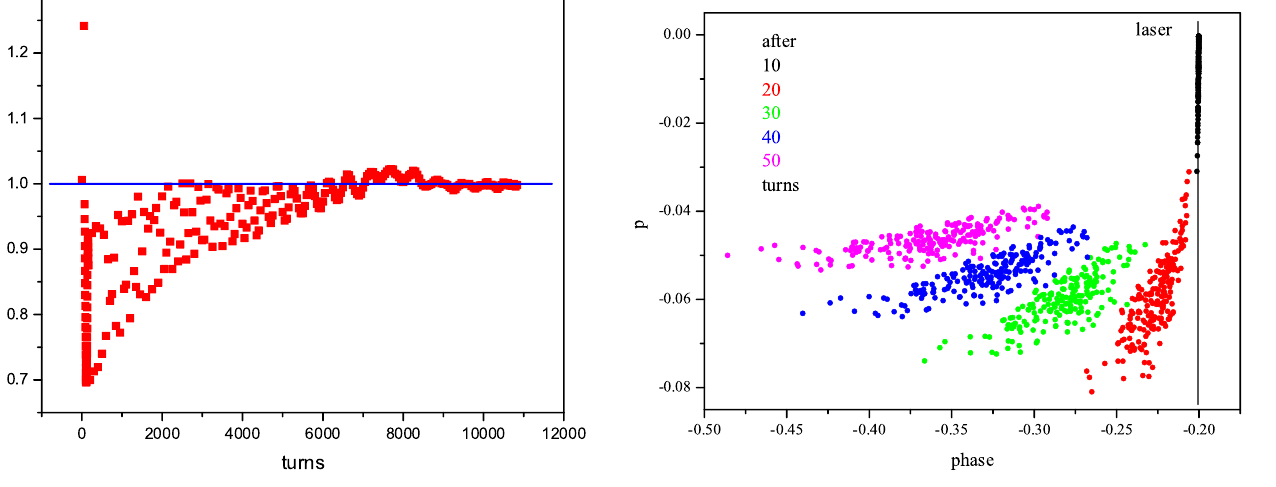
FIG. 8. (Color) Snapshots of macroparticle distributions during the interaction with an intense laser pulse matched with the synchronous particle, for the ILC YAG Compton ring (phase origin at zero of the initial rf